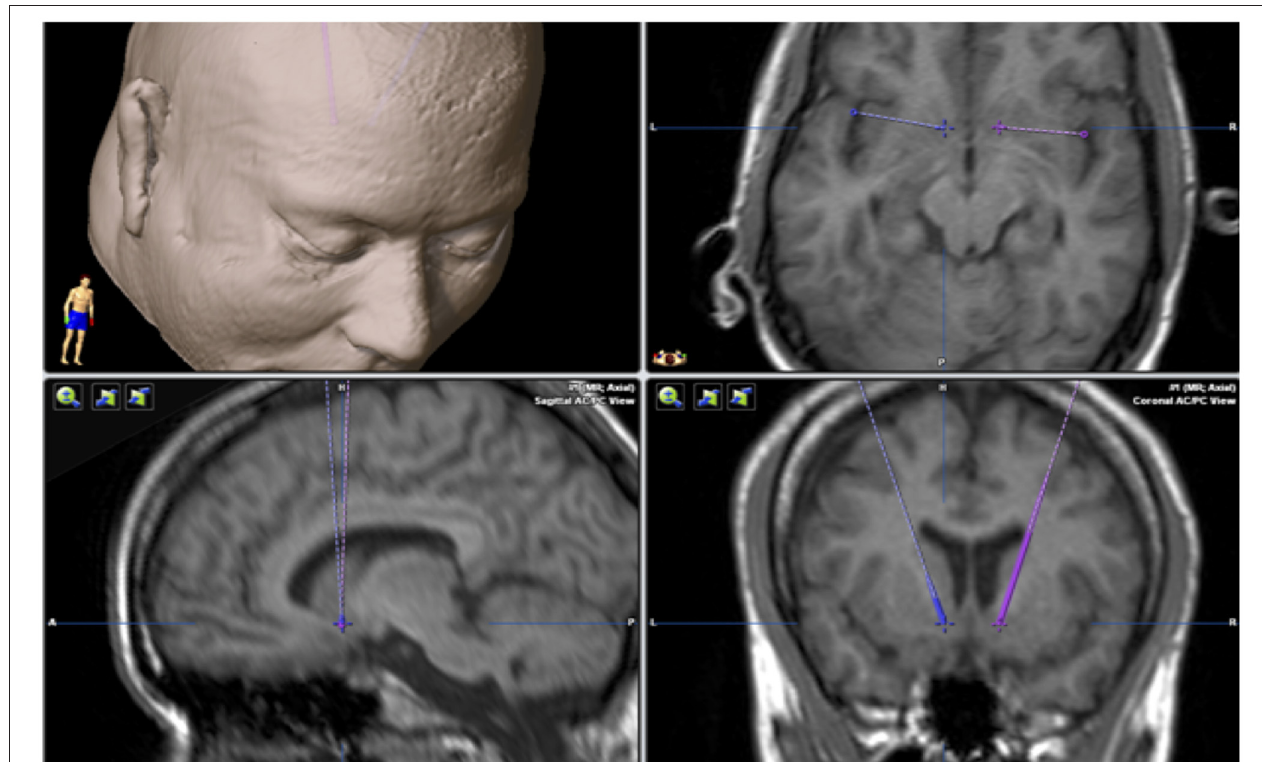
FIGURE 3 | Stereotactic planning. MRI examination with a planned target in the nucleus accumbens in 3 planes. The cross points to the target, and the solid and dashed lines indicate the course of the electrodes in the brain.